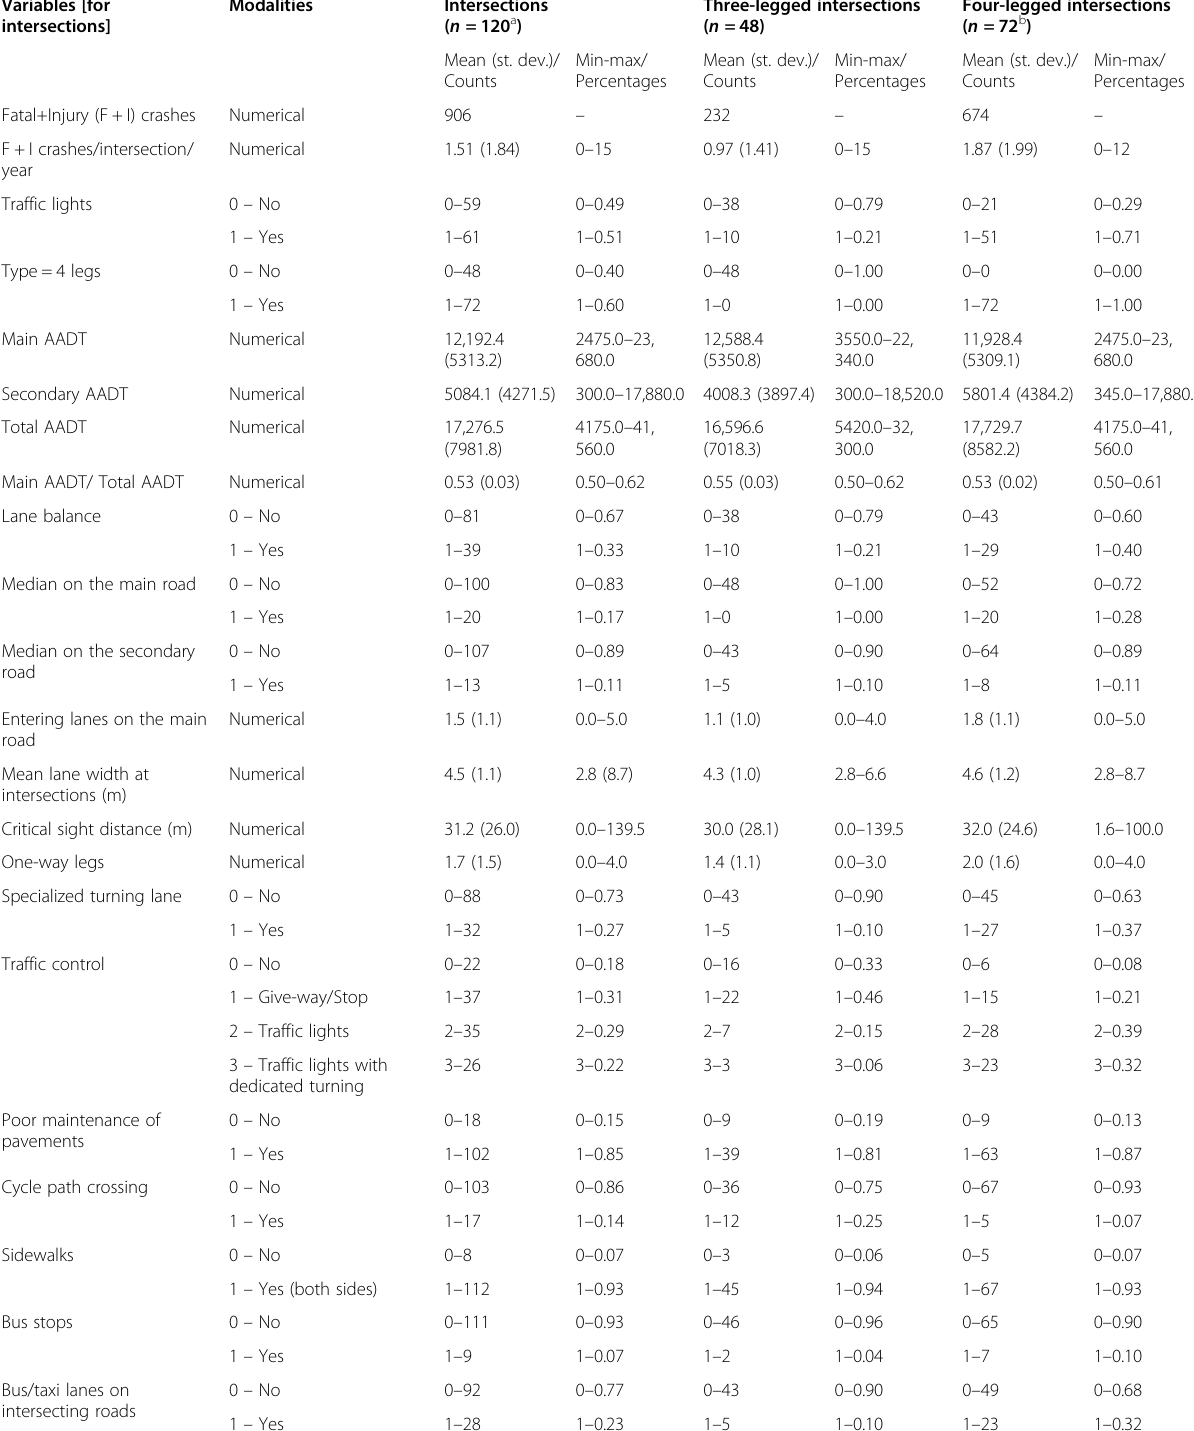
Table 1 Descriptive statistics of potential crash predictors for segments and intersections